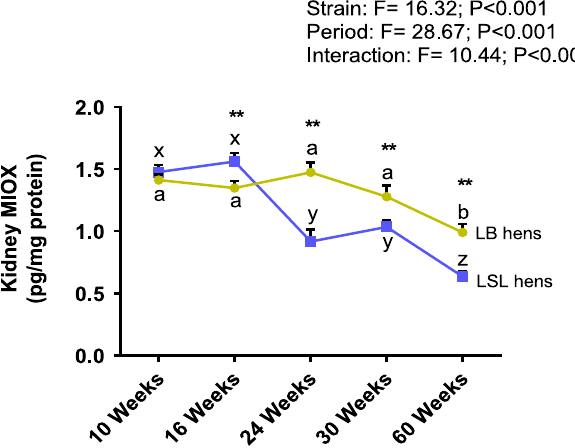
Figure 1. Concentrations of myo -inositol oxygenase (MIOX) in kidneys of LB (olive) and LSL (navy) hens at five productive periods. Symbols show mean ± SEM (n = 10 hens per strain and period). Two-way ANOVA followed by the post-hoc test Tukey HSD (Honestly Significant Difference) were used for statistical analysis. Different letters indicate significant differences within strain at different productive periods (p < 0.05) whereas **indicate highly significant differences (p < 0.01) between strains at the same productive period. F-values showed the ratio of between-groups to within-groups